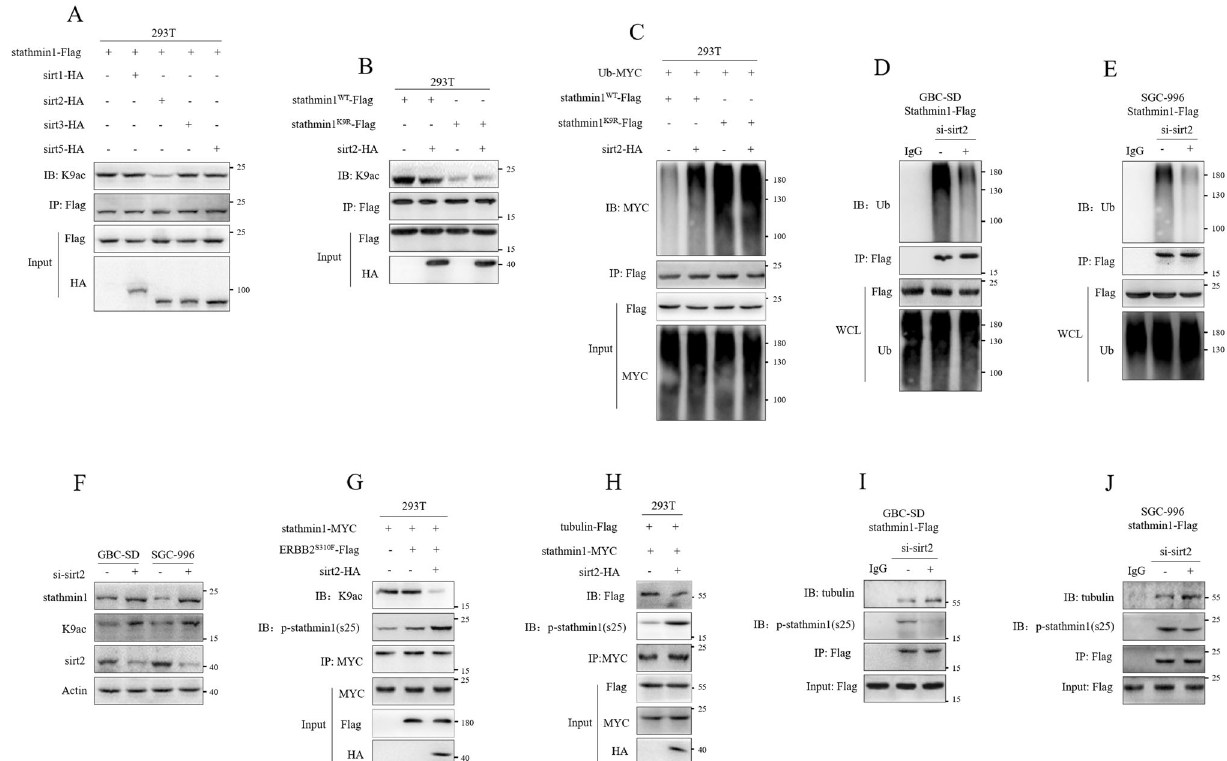
Fig. 5 Sirt2 mediated the deacetylation of stathmin1. Immunoprecipitation detection of K9 acetylation of stathmin1, A after co-transfection of plasmids of sirt1-HA, sirt2-HA, sirt3-HA and sirt5-HA with stathmin1-Flag to 293 T cells for 48 h, B after transfection of plasmids of stathmin1 WT -Flag, stathmin1 K9R -Flag and sirt2-HA to 293 T cells for 48 h, C after transfection of plasmids of stathmin1 WT -Flag, stathmin1 K9R - Flag, sirt2-HA and Ub-MYC to 293 T cells for 48 h. D , E Immunoprecipitation assay of ubiquitination of stathmin1 in GBC-SD and SGC-996 stable cells with sirt2 knockdown by targeting siRNA. F Western blot detection of stathmin1 protein and K9 acetylation levels. The siRNA targeting sirt2 was transfected to GBC-SD and SGC-996 cells for 48 h, nontargeting siRNA as control. G Immunoprecipitation detection of the phosphorylation and acetylation levels of stathmin1. The plasmids of stathmin1-MYC, ERBB2 S310F -Flag and sirt2-HA were transfected to 293 T cells for 48 h. Co-immunoprecipitation detection of the interaction of stathmin1 and tubulin, H after transfection of plasmids of stathmin1-MYC, Tubulin-Flag and sirt2-HA to 293 T cells for 48 h, I , J in GBC-SD and SGC-996 stable cells after sirt2 knockdown. Results shown as means ± s.d represented at least three independent revealed the underlying mechanism of K9 acetylation of stathmin1 indicated an E3 ligase, RLIM could regulate the stability of and provided a potential target for GBC therapy. stathmin1 protein [20, 21]. We con fi rmed that K9 acetylation inhibited the degradation of stathmin1 through disturbing the combination of acetylated stathmin1 and RLIM. MATERIALS AND METHODS Cell migration is a polarized cellular process involving the Cell culture cytoskeletal systems rearrangement conferring the metastatic properties of cancers [28 – 31]. The microtubule regulation viability of stathmin1 indicated its roles on cell migration, which is also veri fi ed in several studies [32 – 36]. K9 acetylation enhanced the activity of stathmin1 to promote GBC metastasis in vivo. Moreover, overexpression of K9 acetylation and stathmi1 protein expression was con fi rmed in GBC tissues. Altogether, K9 acetylation of stathmin1 by PCAF inhibited ubiquitination degradation of stahmin1, but promoted its microtubule-destabilizing activity, which caused gallbladder cancer metastasis (Fig. 8o). Our study